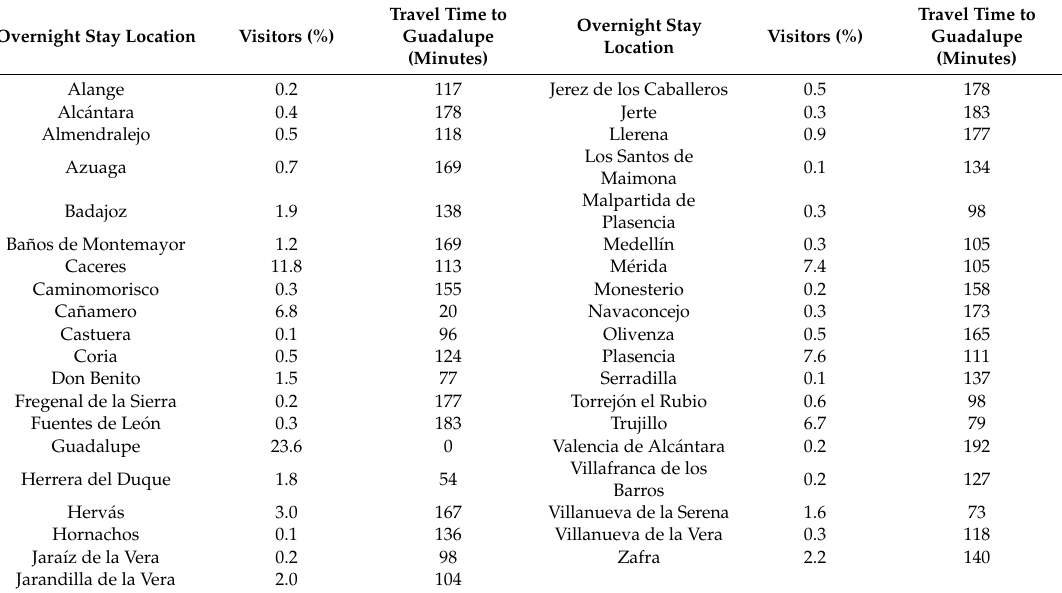
Table 9. Flows of visitors towards the